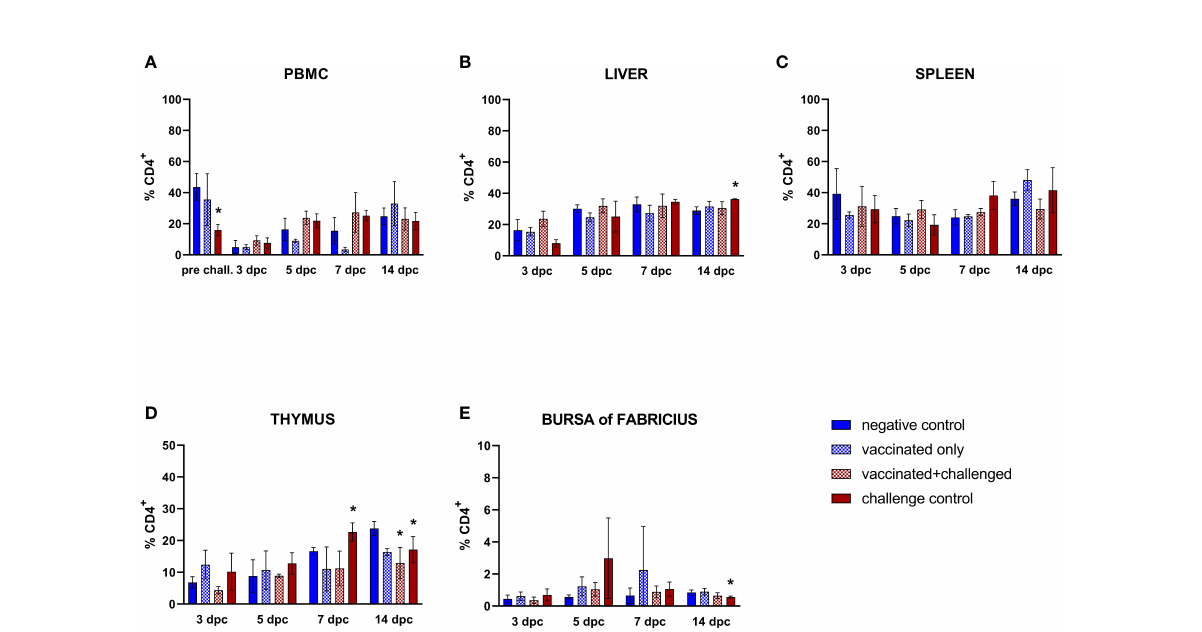
FIGURE 5 Relative number of CD4 + T lymphocytes within total CD45 + cells measured via FCM for each experimental group throughout the study in PBMC (A) , liver (B) , spleen (C) , thymus (D) , and bursa of Fabricius (E) . Data for the two vaccinated groups (vaccinated only and vaccinated+challenged) are merged to determine values in PBMCs pre-challenge. Asterisks represent signi fi cant difference compared to the negative control at each time point ( p ≤ 0.05).